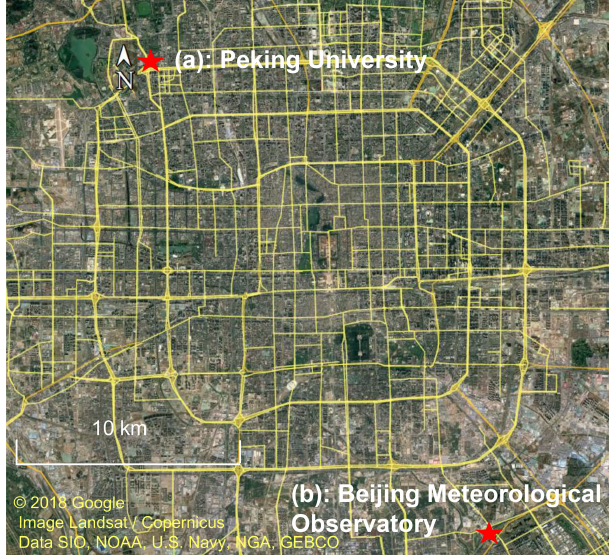
Figure 1. Sample sites in this study (red stars): (a) Peking Univer- sity and (b) Beijing Meteorological